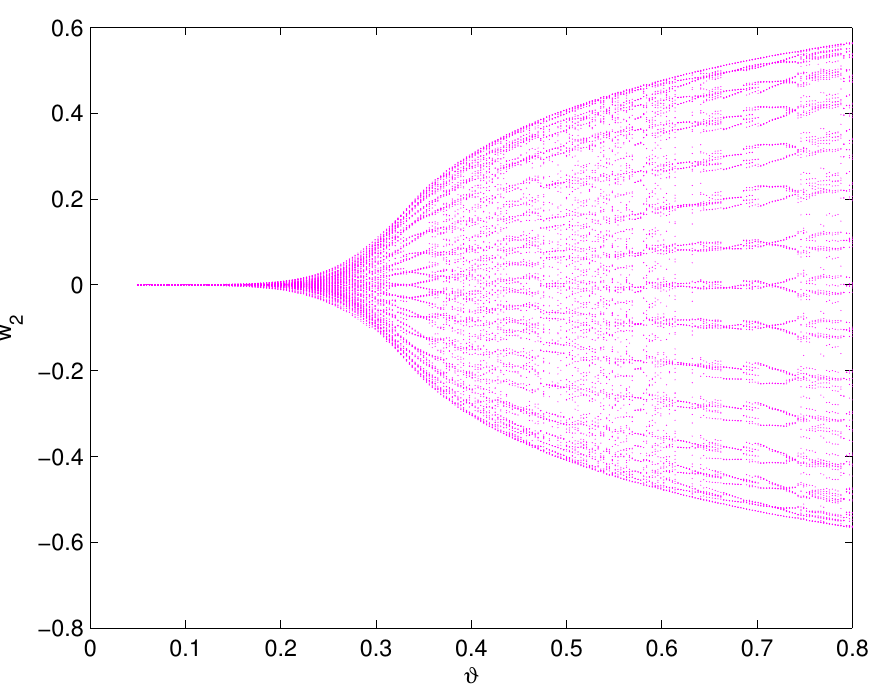
Figure 18. Bifurcation graph of system (73): the time delay ϑ versus the variable w 2 . The bifurcation number is 0.32.